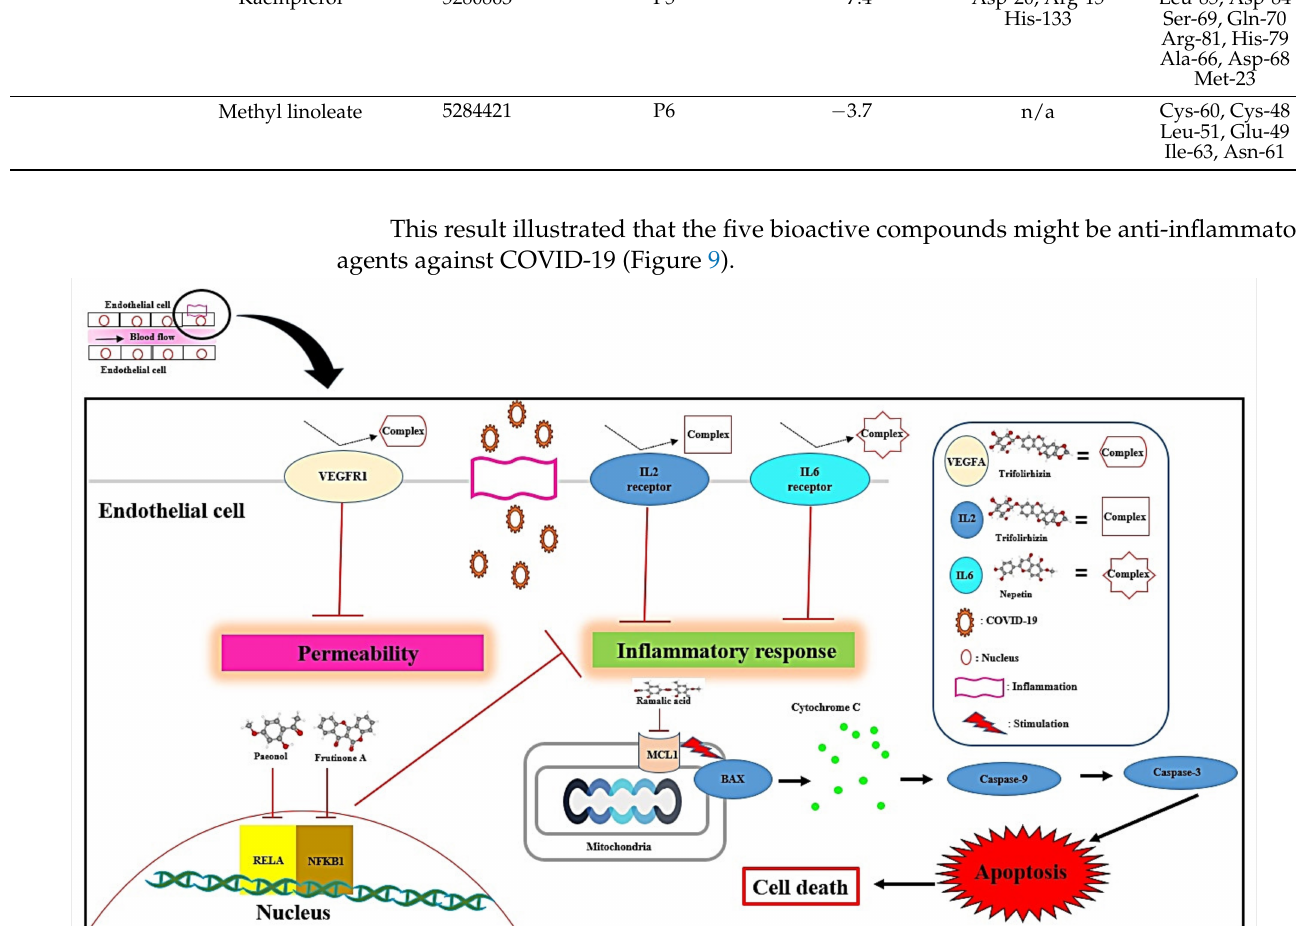
Figure 9. Illustration of key findings in this